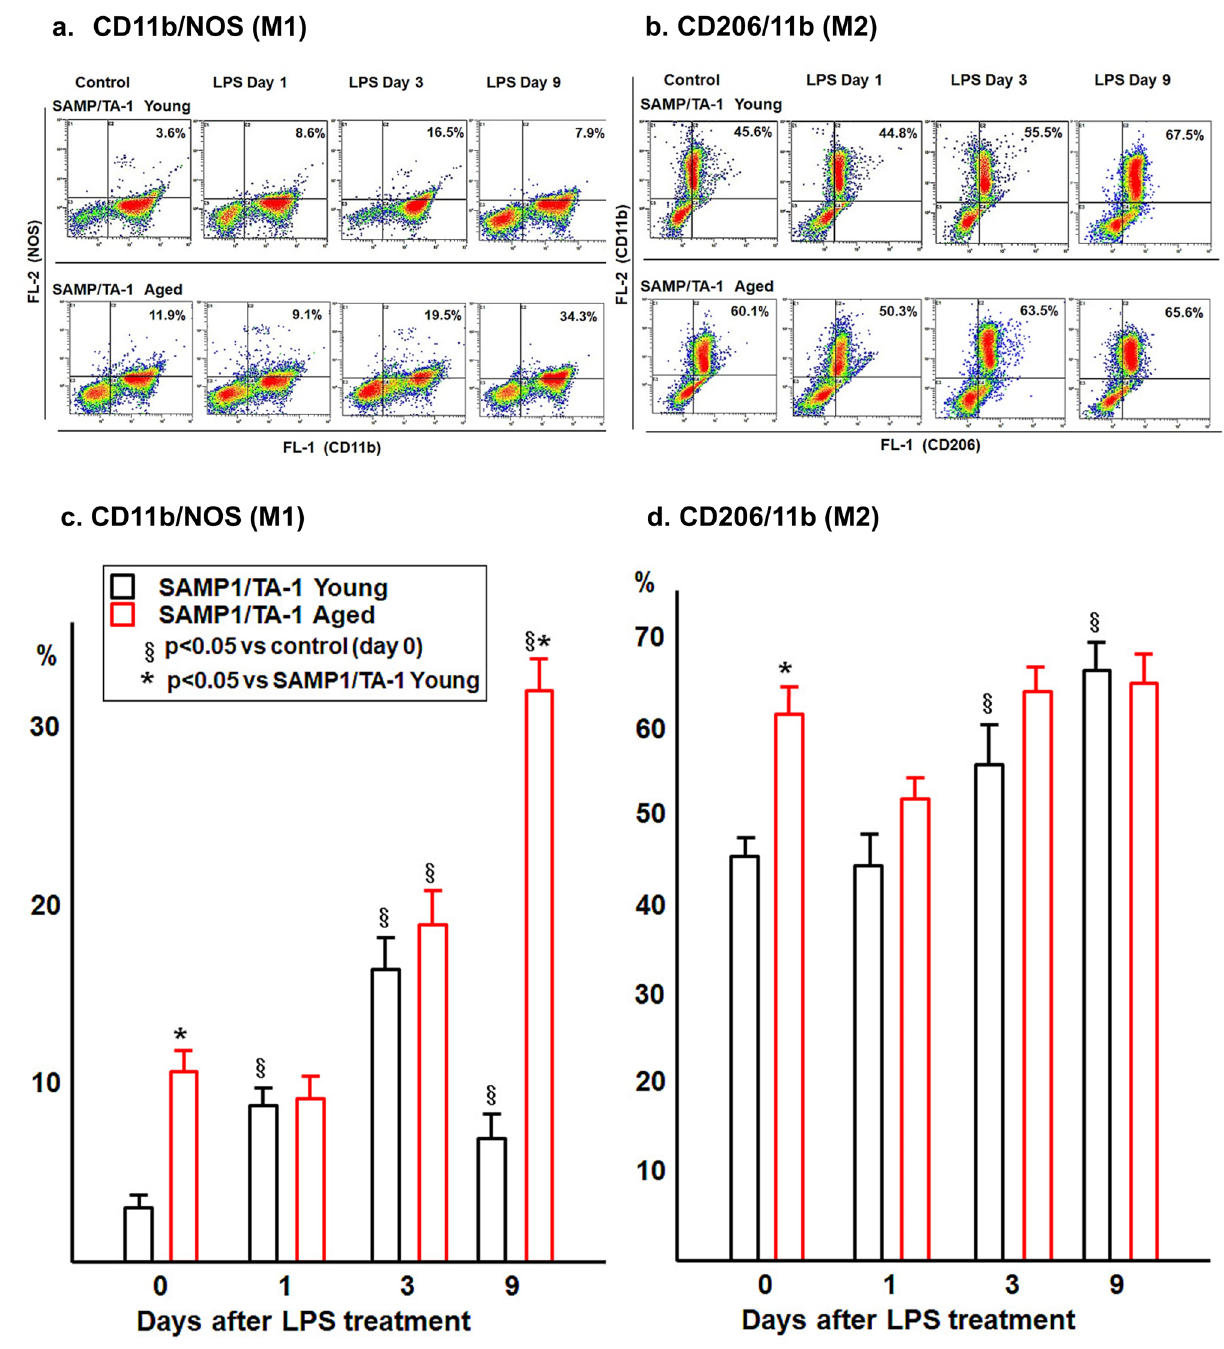
Figure 6. The proportions of M1 and M2 macrophages in BM of young and aged mice. The proportions of M1 and M2 macrophages in the BM of young and aged SAMP1/TA-1 mice after LPS treatment are shown. Typical dot plot histograms of two-color flow cytometry determined by CD11b (FL-1) and NOS (FL-2) for detecting M1 macrophages ( a ) and by CD206 (FL-1) and CD11b (FL-2) for detecting M2 macrophages ( b ) are shown. Changes in the proportions of M1 and M2 cells after LPS treatment are shown in ( c ) and ( d ). The samples of macrophages of the BM were obtained from non-treated control mice (day 0) and from treated mice at 1, 3, and 9 days after dosing with 25 µg of LPS. Each bar represents the mean ± SD. § P < 0.05 vs. control (day 0) and *P < 0.05 vs. SAMP1/TA-1 young